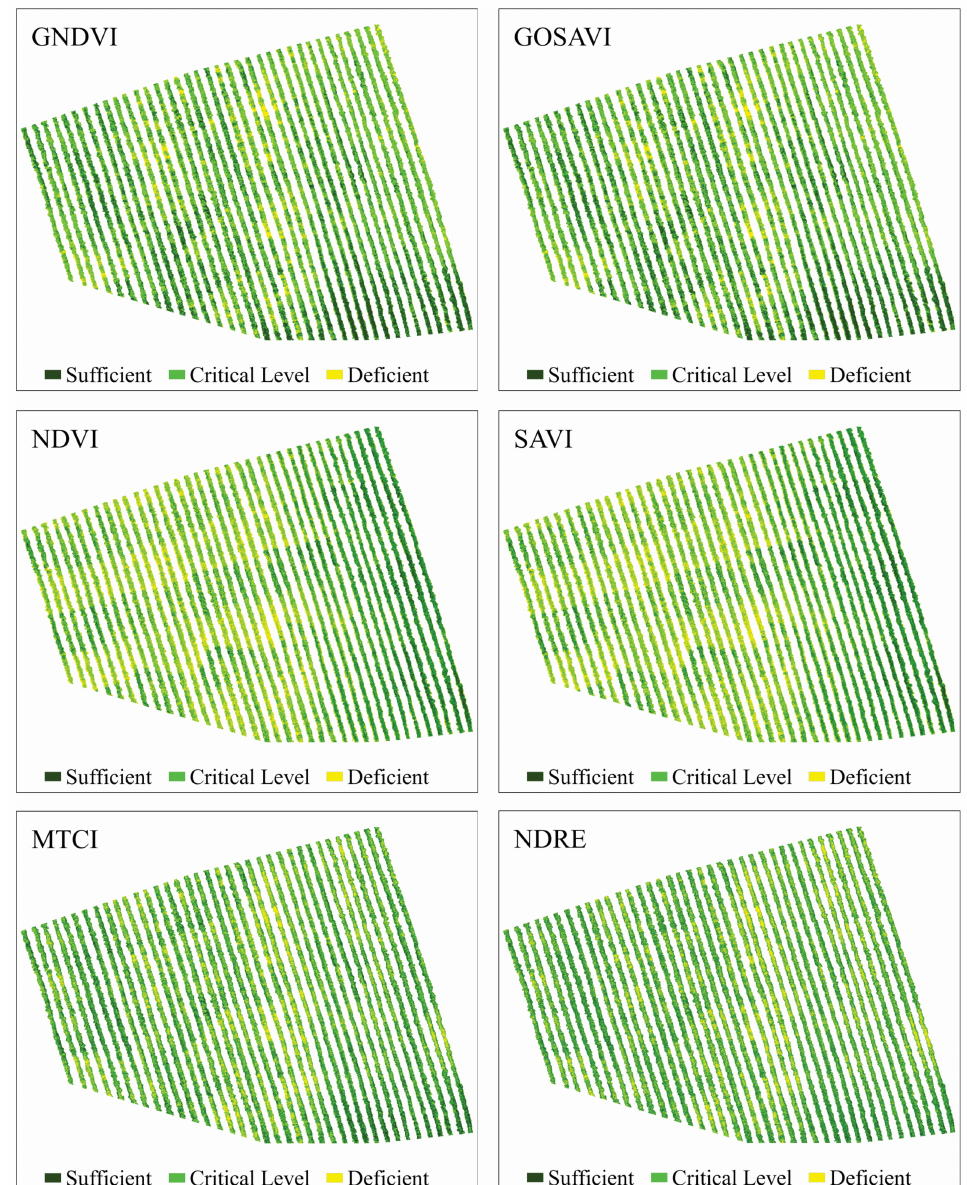
Figure 6. Predictive maps of the N content spatial distribution in coffee leaves, obtained from the classification of images using RF from vegetation indices Green Normalized Difference Vegeta- tion (GNDVI), Green Optimized Soil Adjusted Vegetation Index (GOSAVI), Normalized Difference Vegetation Index (NDVI), Soil Adjusted Difference Vegetation Index (SAVI), Medium Resolution Imaging Spectrometer (MERIS) Terrestrial Chlorophyll Index (MTCI), and Normalized Difference Red Edge